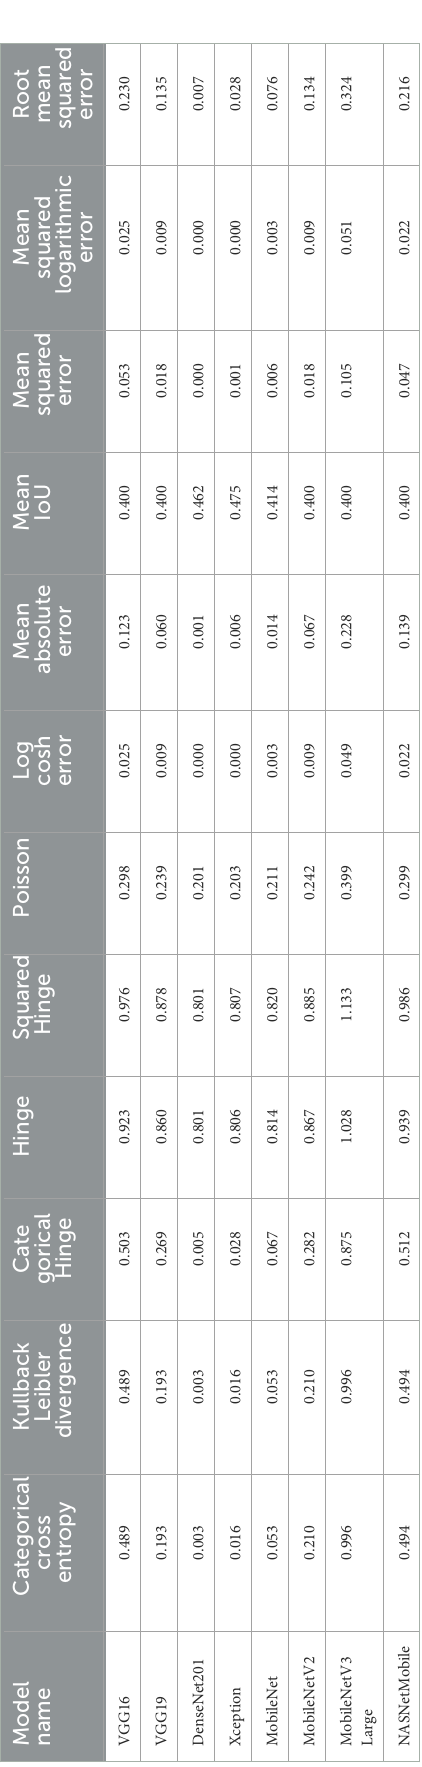
Algorithm 1 explains the SpaSA meta-heuristic optimizer population (i.e., solution) updating